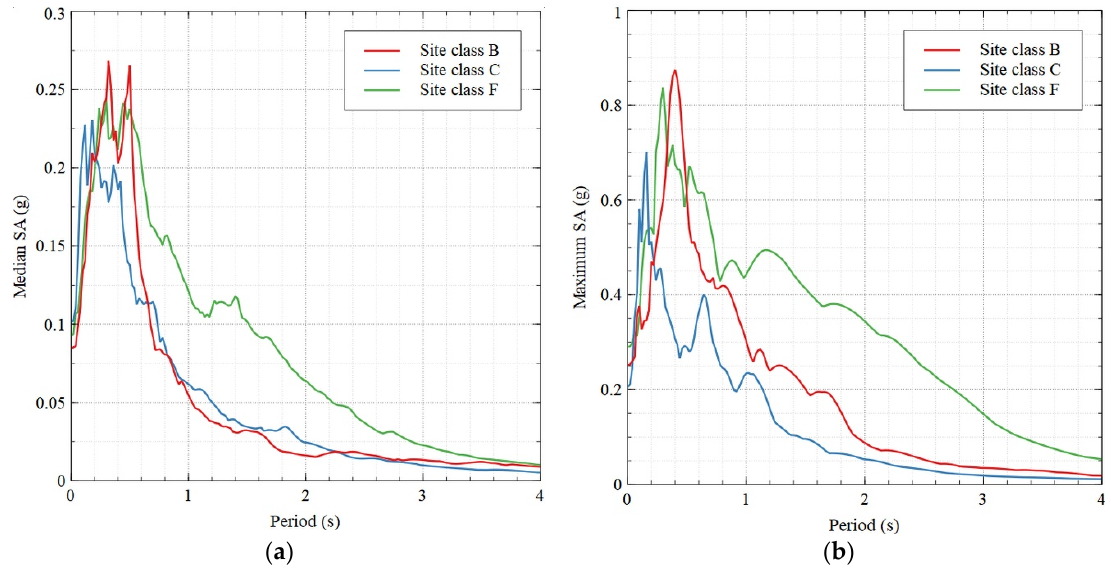
Figure 2. ( a ) The median spectral accelerations as a function of the site class; ( b ) the maximum spectral accelerations as a function of the site class.